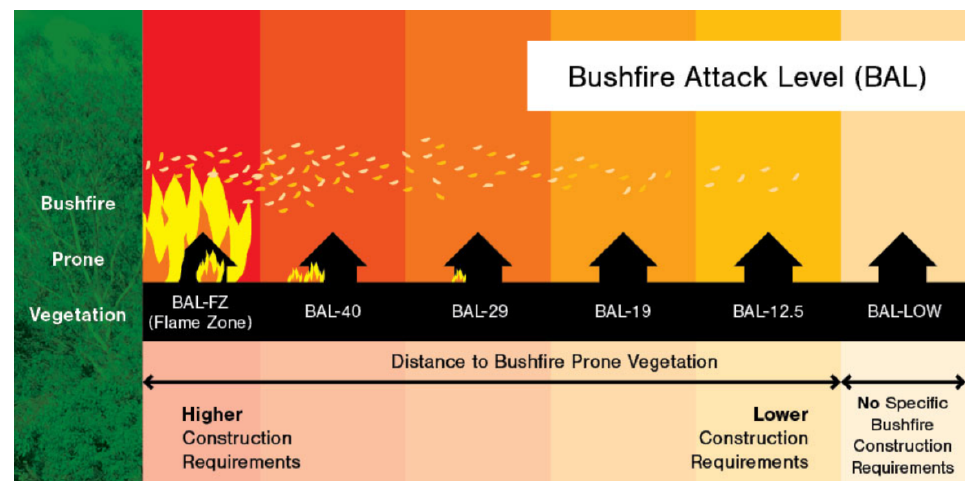
Figure 5. Pictorial description of Bushfire Attack Level (BAL) ratings [54].